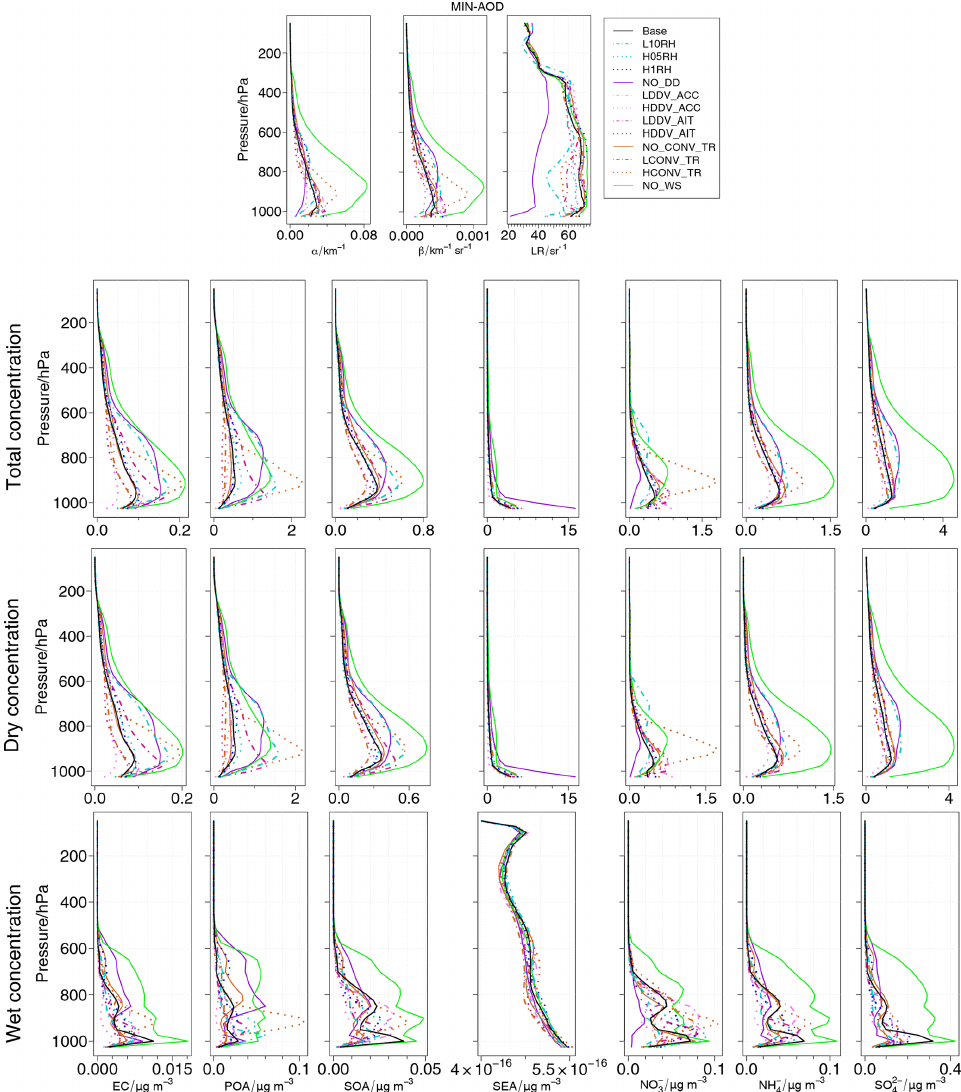
Figure 5. As Fig. 3 but over the MIN-AOD location.